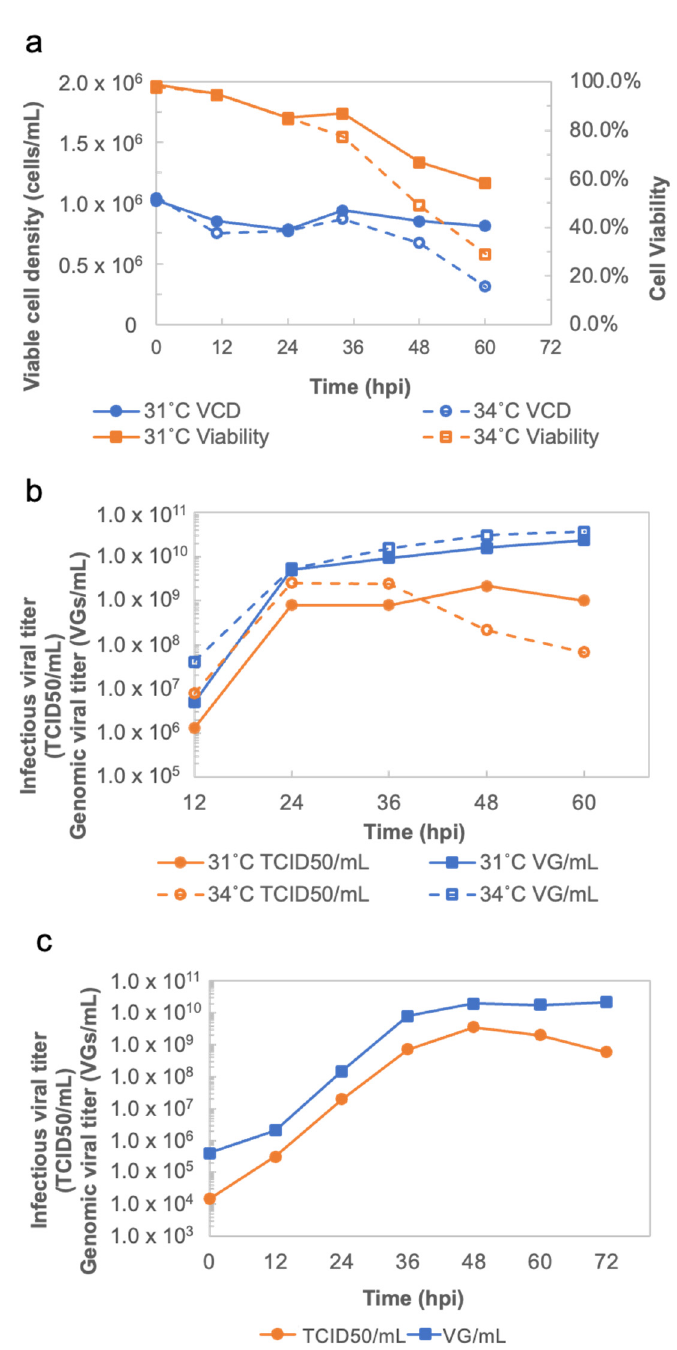
Figure 2. ( a ) Viable cell density and cell viability curves of rVSV-SARS-CoV-2 production at 31 °C and 34 °C in Ambr250. ( b ) Infectious viral titer and genomic viral titer curves of rVSV-SARS-CoV-2 production at 31 °C and 34 °C in Ambr250. ( c ) Infectious viral titer and genomic viral titer curves of rVSV-SARS-CoV-2 production in the batch